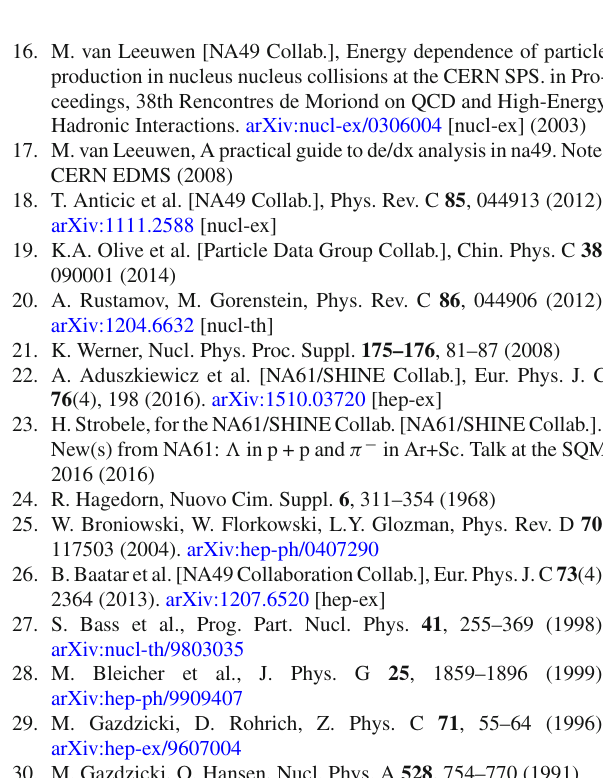
Fig. 48 Survival probability of tracks between the last measured point in the MTPC and the ToF-L or ToF-R walls for p + p interactions at 158 GeV /